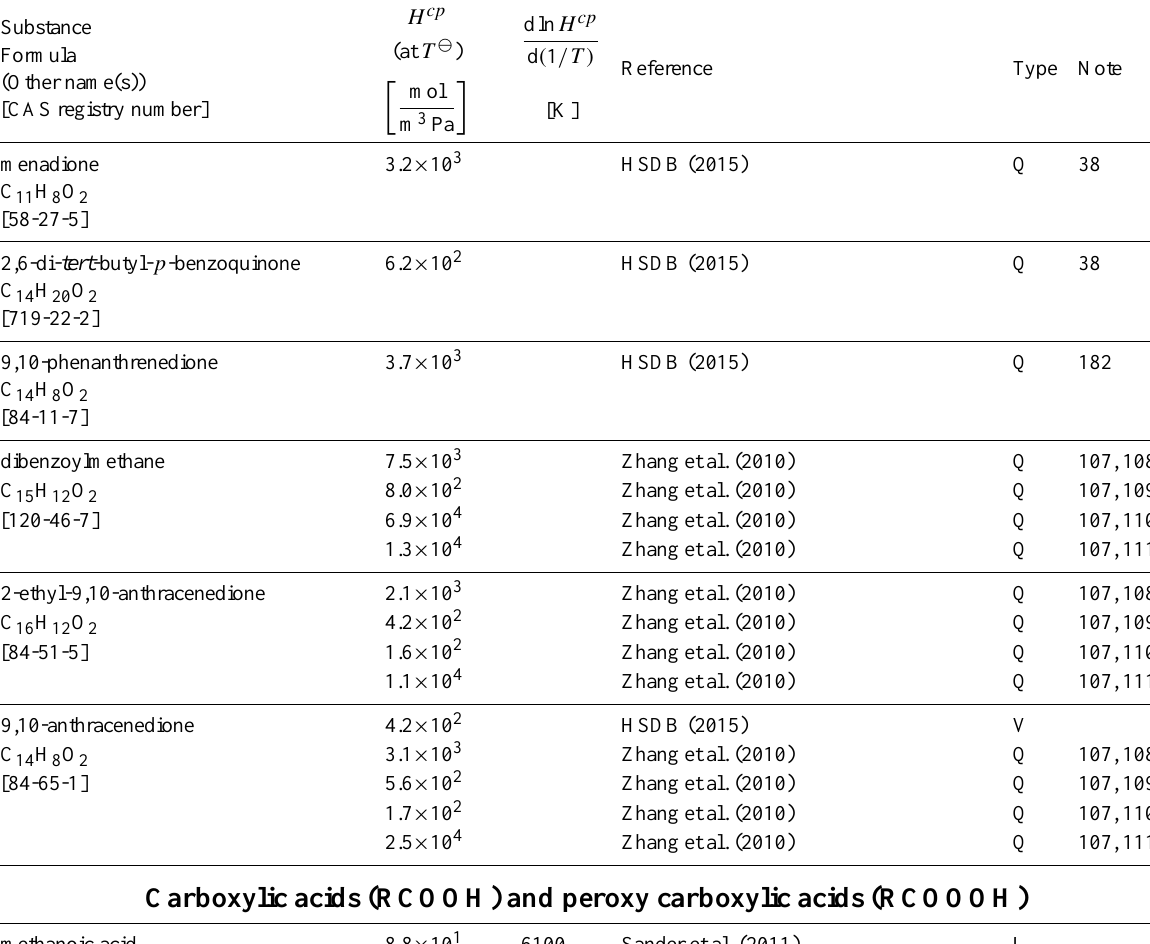
Table 6: Henry’s law constants for water as solvent